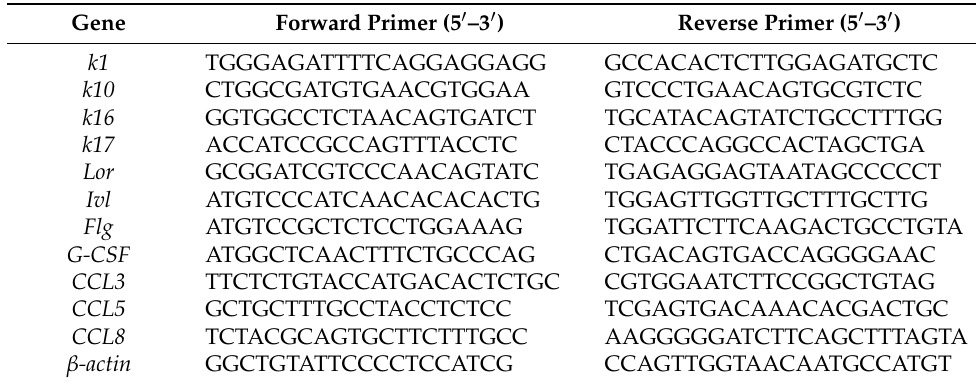
Table 2. Primers Used in the Real-Time